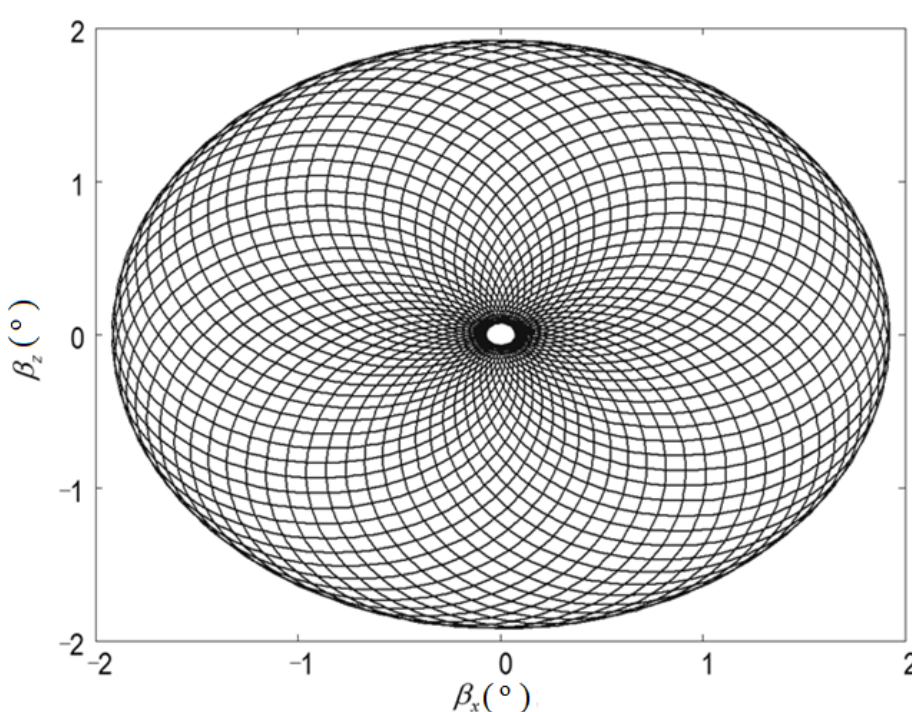
Figure 3. The area of scanned airspace in the first operating mode of the seeker.